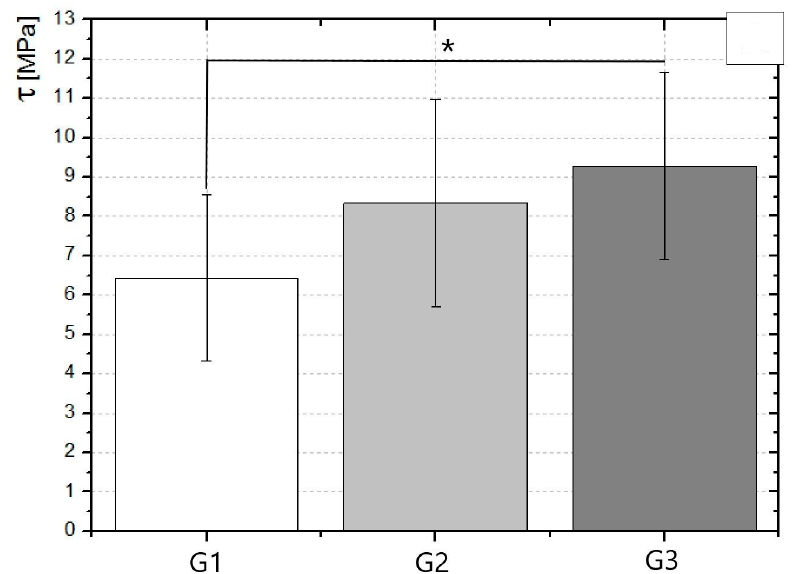
Figure 3. Comparison of average stress–strain values obtained in the shear bond strength test for 3 measurement groups: G1, G2 and G3, * p < 0.05.